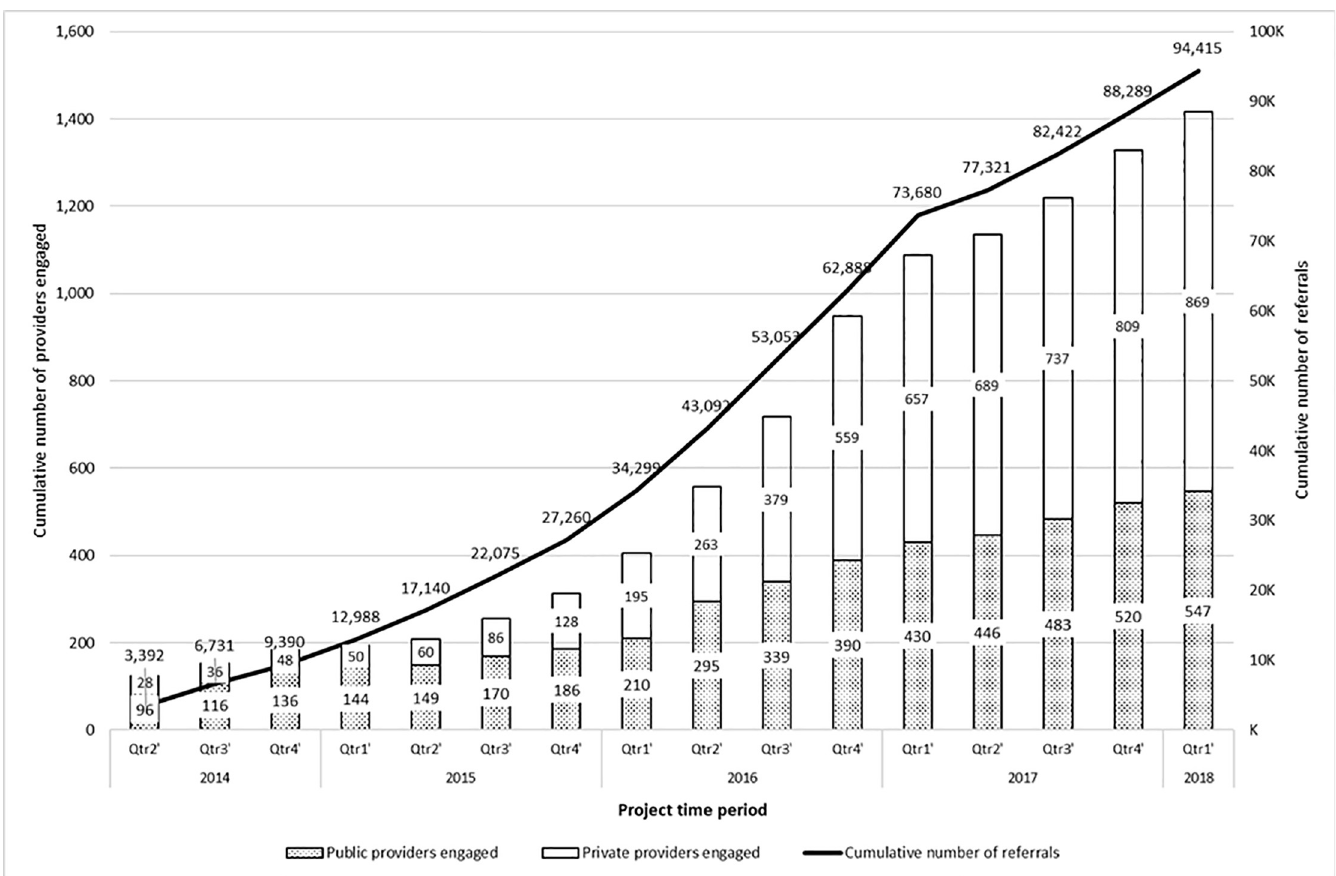
Fig 2. Cumulative number of public and private facilities linked and cumulative number of referrals in the project from ten cities in India, 2014–2018 (n = 94415).